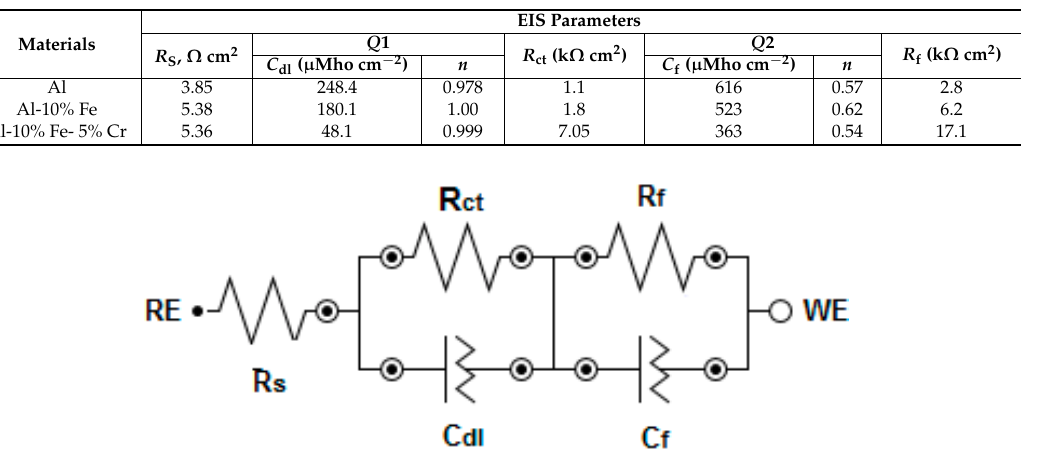
Figure 6. Equivalent circuit fitting for EIS.